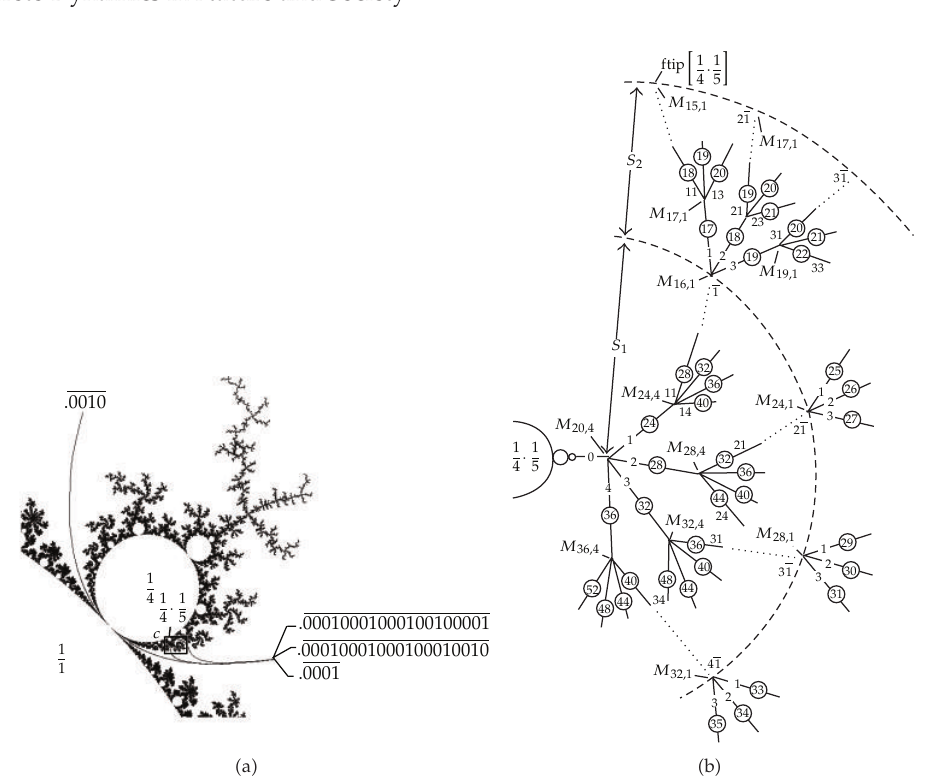
Figure 6: (cid:5) a (cid:6) Magnification of the rectangle b of Figure 4, corresponding to shrub (cid:5) 1 / 4 (cid:6) . Shrub (cid:5)(cid:5) 1 / 4 (cid:6) · (cid:5) 1 / 5 (cid:6)(cid:6) is framed in the rectangle c . (cid:5) b (cid:6) Sketch of shrub (cid:5)(cid:5) 1 / 4 (cid:6) · (cid:5) 1 / 5 (cid:6)(cid:6) .